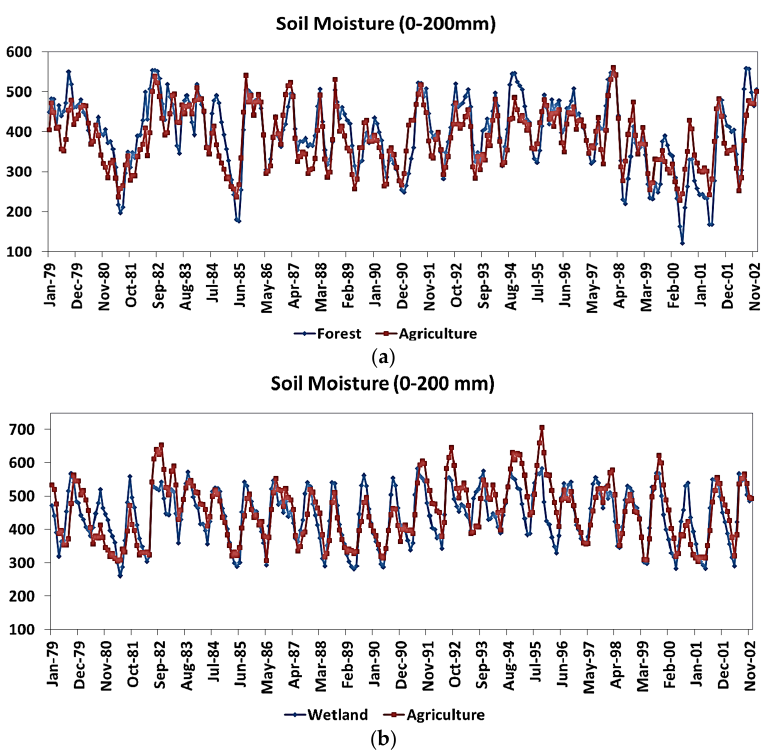
Figure 7. ( a ) Time series monthly soil moisture (0–200 mm) patterns for Northeast Florida; ( b ) Time series monthly soil moisture (0–200 mm) patterns for South